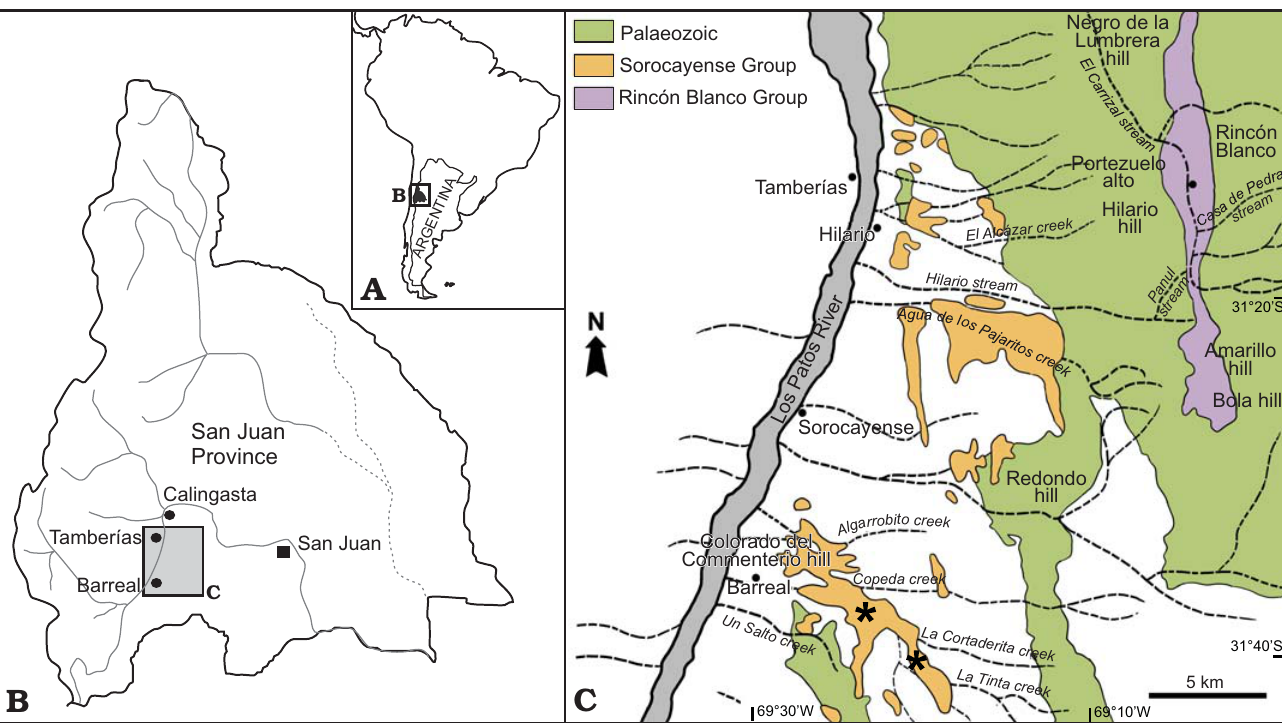
Fig. 1. Geographic location of study area in the San Juan Province, Argentina ( A , B ). Geologic map showing the sampled localities (asterisks) at Cortaderita and La Tinta creeks, near Barreal ( C